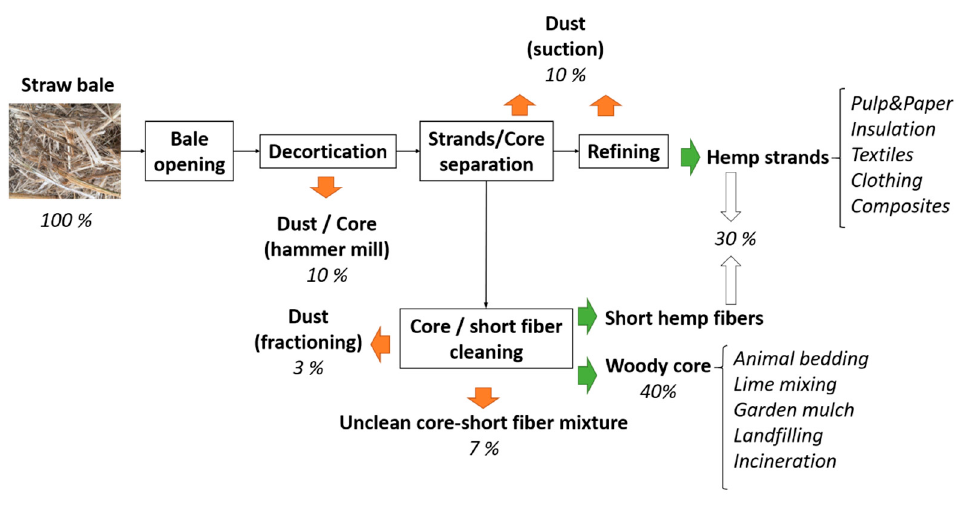
Figure 1. Industrial processing of hemp straw [14,15].